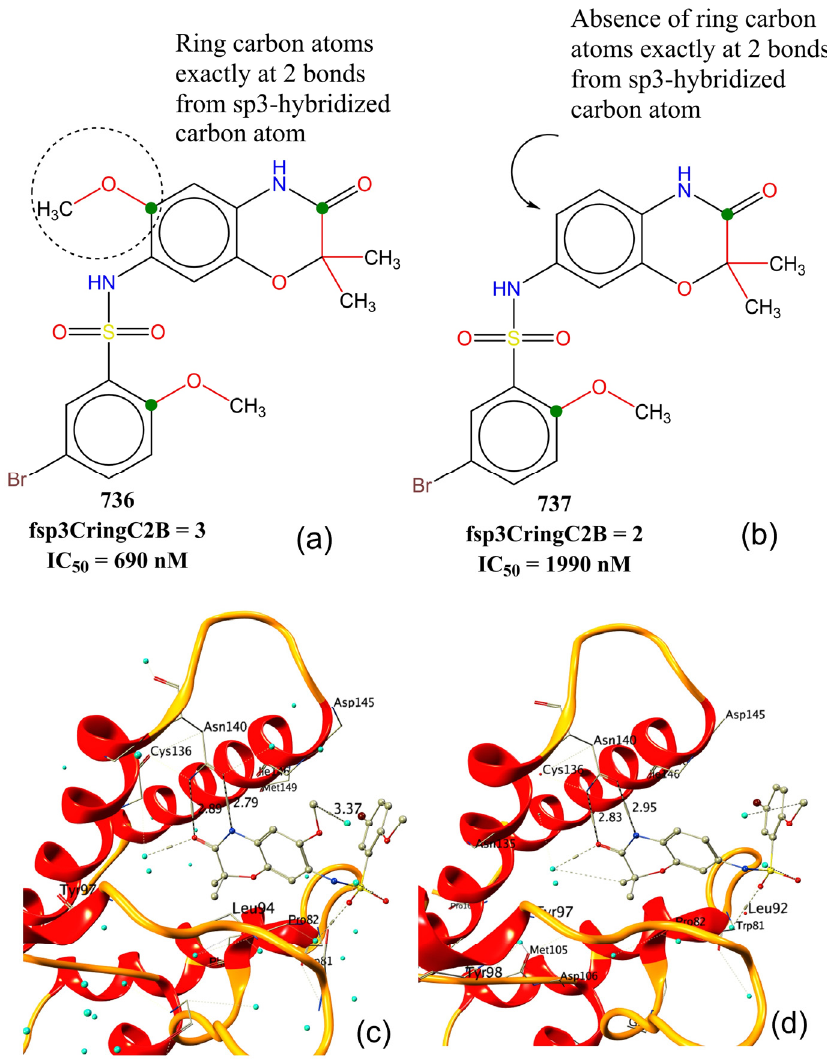
Figure 4. Comparison of BRD-4 inhibitory activity of molecule 736 with 737 with respect to fsp3CringC2B: ( a , b ) 2D representation of 736 and 737; ( c , d ) X-ray-resolved structures of 737 (pdb: 5z1r) and 736 (pdb: 5z1s). Cyan coloured spheres represent water molecules, and dashed lines signify interactions and distances in Å.